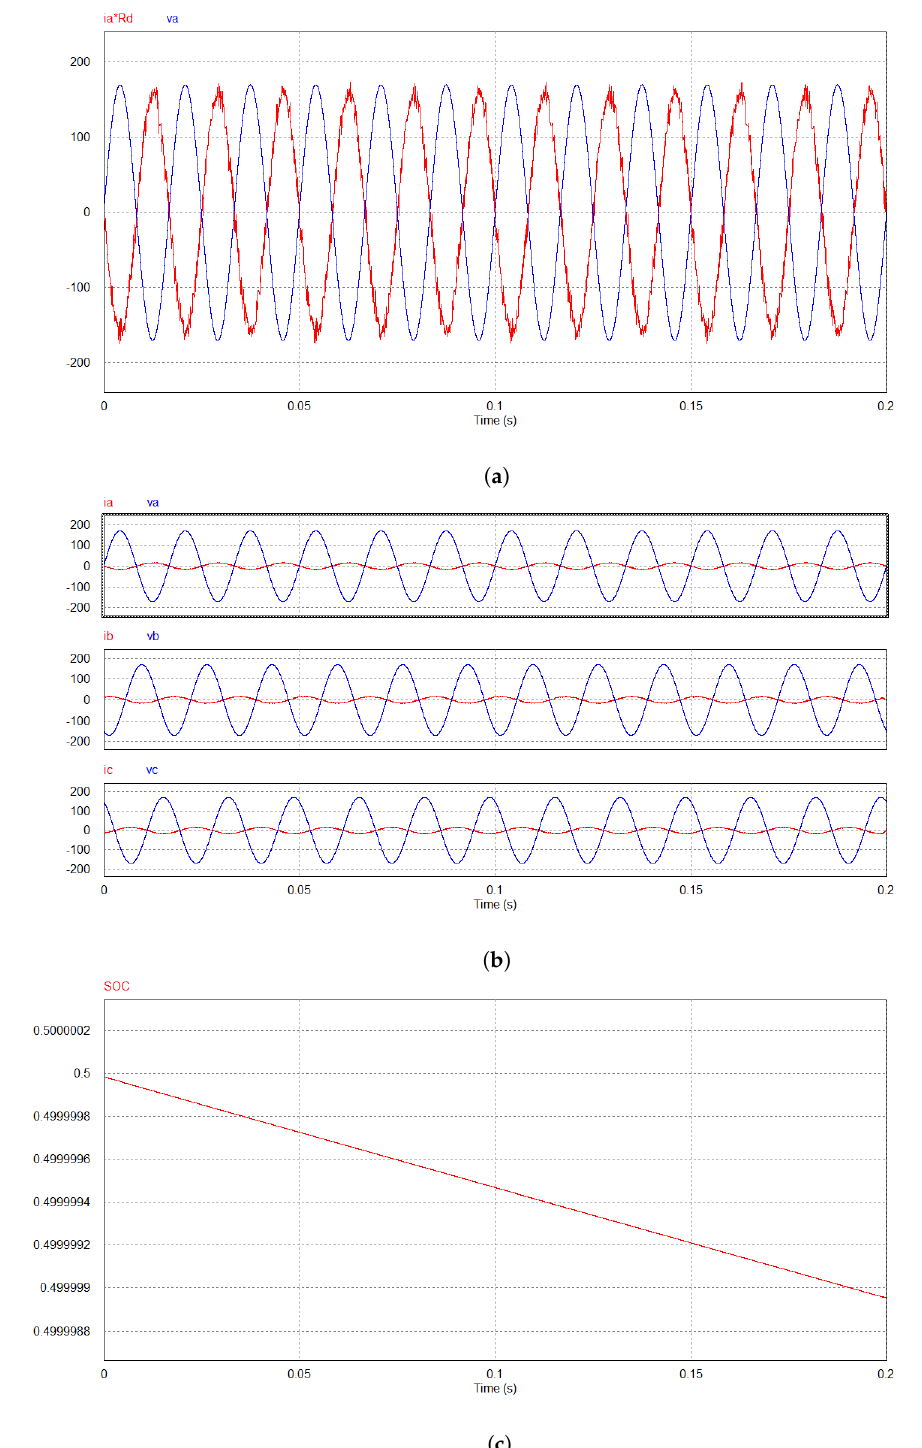
Figure 6. Simulation results for R d = − 10 Ω . ( a ) The voltage of Phase-a and its current multiplied by R d . ( b ) The input voltage and current of each phase. ( c ) The battery